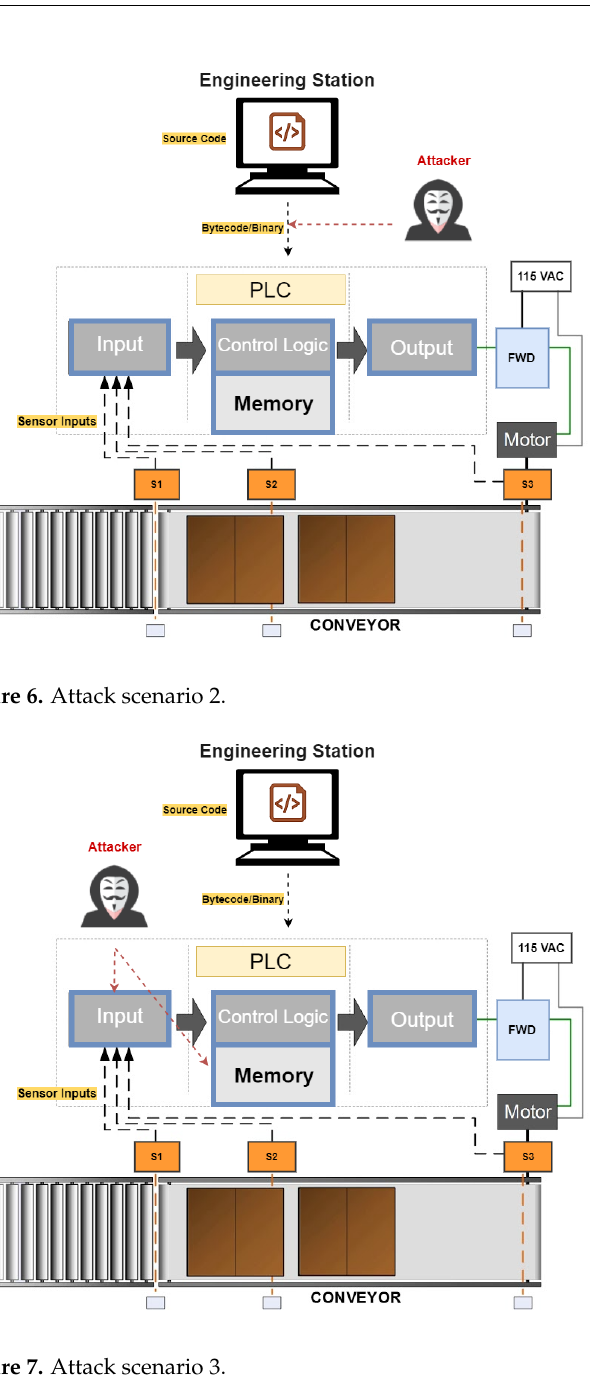
Figure 7. Attack scenario